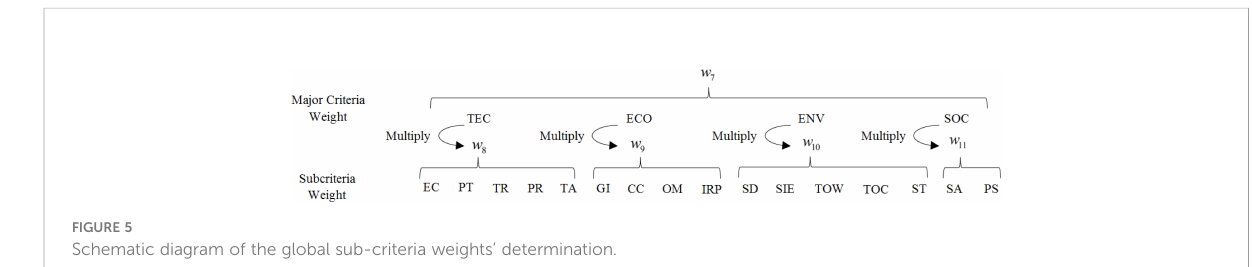
FIGURE 5 Schematic diagram of the global sub-criteria weights ’